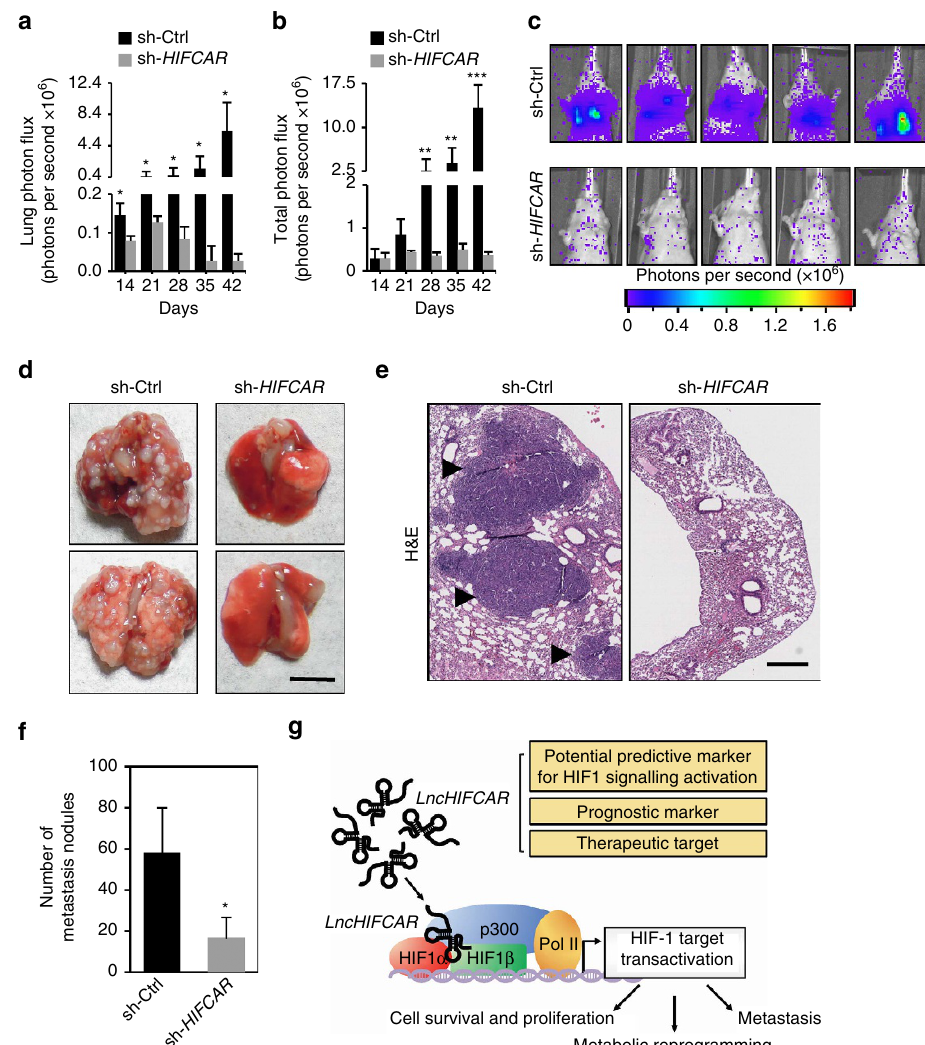
Figure 6 | LncHIFCAR is an oncogenic driver of metastatic cascade. SAS cells stably expressing control (sh-Ctrl) or LncHIFCAR knockdown (sh- HIFCAR ) construct with firefly luciferase labelling were injected into the tail vein of nu/nu mice ( n ¼ 10 each group). The metastatic tumour nodules in the lungs of the animals were monitored weekly by luciferin injection and IVIS imaging. ( a , b ) The bioluminescence intensity of the lung area ( a ) and total signal ( b ) of the animals were quantified at the indicated time points. ( c ) Representative bioluminescence images of 5 mice in each group at day 42 after tail vein injections. ( d , e ) Representative images of the metastatic lung nodules ( d ; scale bar, 5mm), and haematoxylin and eosin (H&E) staining ( e ; scale bar, 500 m m) of the lung sections from mice in each group 6 weeks after tail vein injections. The black arrowheads indicate the metastatic nodules. ( f ) Quantification of the number of pulmonary nodules in each mice group 6 weeks after tail vein injection. ( g ) A proposed model that depicts how lncRNA LncHIFCAR acts as a HIF-1 a co-activator via its interaction with HIF-1 a that contributes to the activation of HIF-1 transcriptional network associating with cancer progression. The possible utility of elevated LncHIFCAR expression as a prognostic biomarker and therapeutic target for OSCC is indicated. Graphs show mean ± s.d. Student’s t -test, * P o 0.05, ** P o 0.01 and *** P o